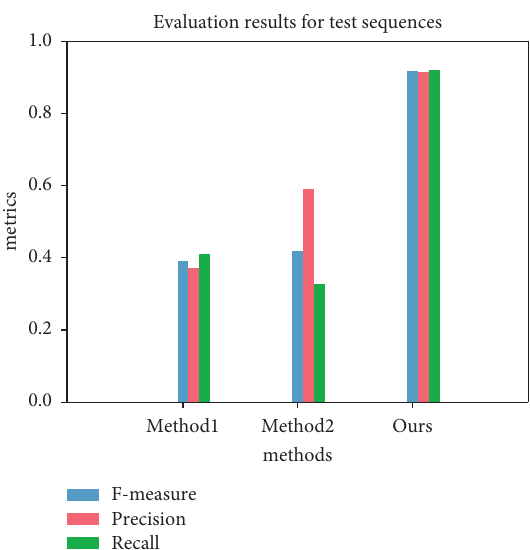
Figure 6: Evaluation results for test sequences.